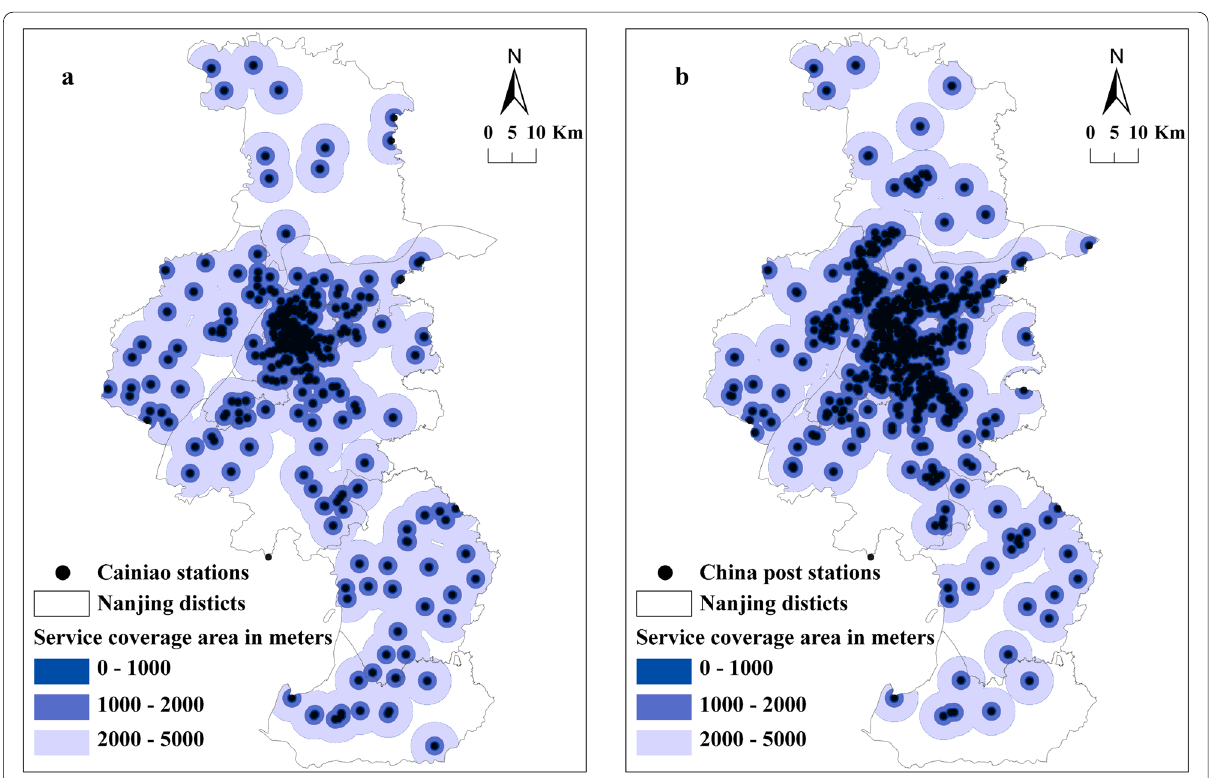
Fig. 7 Various accessibility modes in term of service coverage